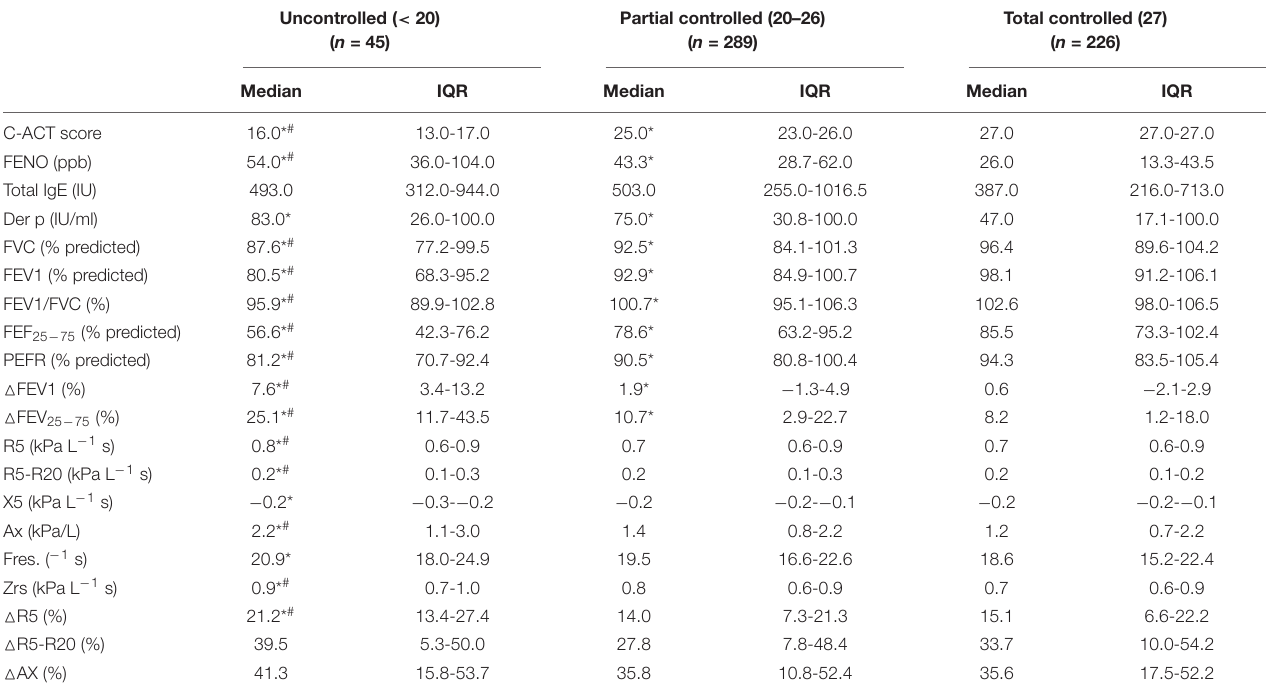
TABLE 4 | FENO, IOS, and spirometry measurements between the total controlled, partial controlled, and uncontrolled groups among asthmatic children. Uncontrolled ( < 20) Partial controlled (20–26) ( n = 45) ( n = 289)